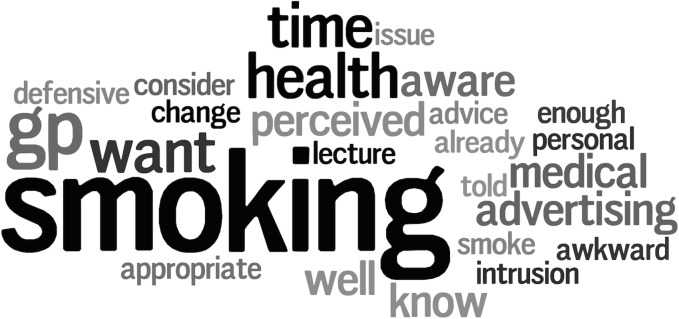
A ‘word cloud’ of the 25 most frequently reported words generated from free-text responses from optometrists (n = 52) to a question asking for the reason(s) why they do not counsel patients regarding smoking behaviors.